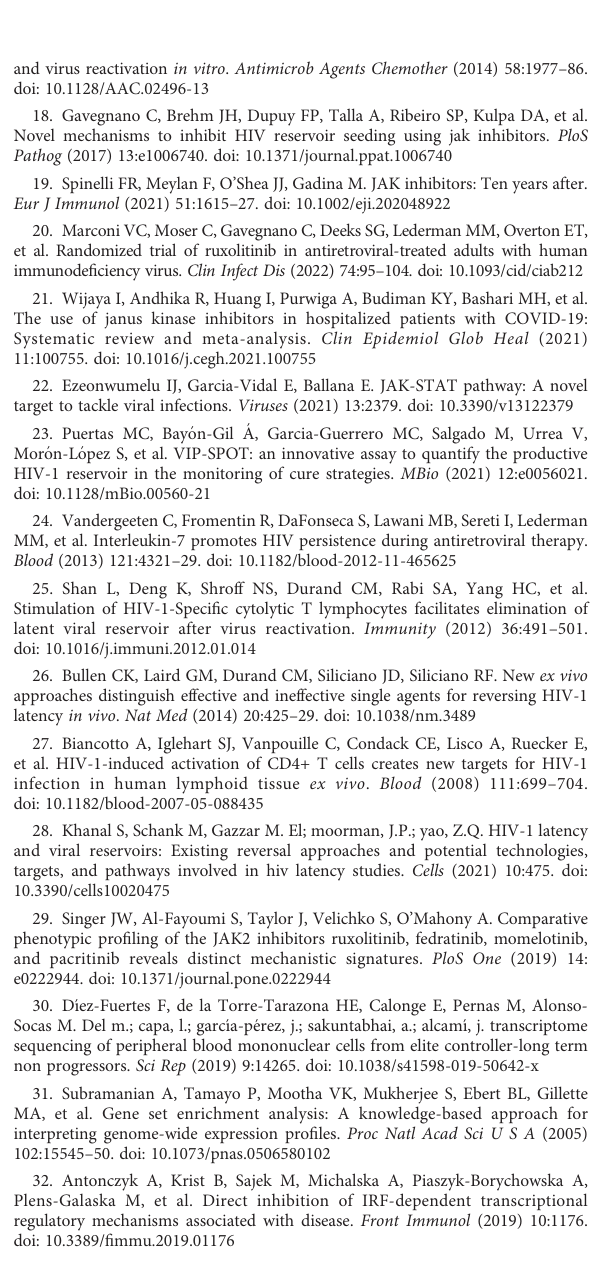
SUPPLEMENTARY FIGURE 5 Fedratinib potently blocks cytokine and NF k B signalling pathways in vitro. (A, B) IL8 and TNF a gene expression of JAKi-treated HL-60 (left panel) and Jurkat (right panel) cells. Relative mRNA expression was measured by quantitative RT-PCR and normalized to GAPDH. (C) Gene expression of leading-edge genes from the Hallmark TNF a via NF k B signalling gene set. Fedratinib treatment condition was used as a reference set for leading- edge genes selection and ranking. Signi fi cantly down- or up-regulated genes are highlighted in blue or red, respectively. (D) Induction of promoters for interferon stimulatory response element (ISRE) and NF k B by JAKi in A549-Dual ™ hACE2-TMPRSS2 cells. All statistical comparisons were performed with Student ’ s t tests. (E) Luciferase activity of mock and